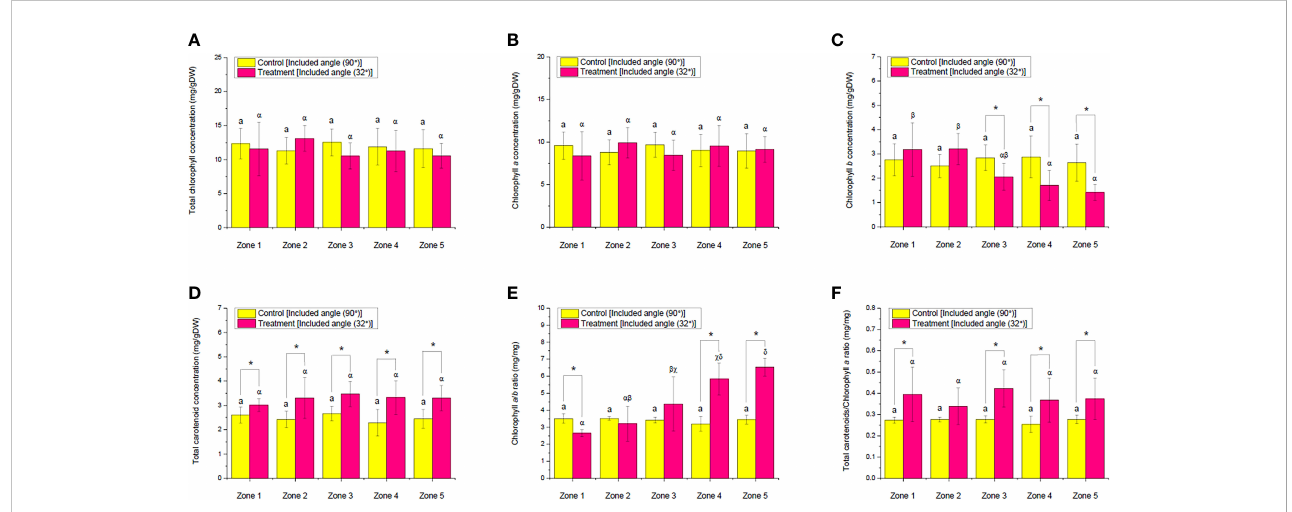
FIGURE 12 Comparison of the concentration of (A) total chlorophylls, (B) chlorophyll a , (C) chlorophyll b and, (D) total carotenoids as well as (E) chlorophyll a / b ratio and (F) total carotenoids/chlorophyll a ratio of choy sum shoots at seedling stage on day 16 grown in an indoor farm rack with and without the application of an adjustable lampshade-type re fl ector (ALR). The asterisks (*) indicate signi fi cant differences found between the control and treatment (Student ’ s t -test; p < 0.05), the lone lowercase letter (a) indicates that there is no signi fi cant difference found among all the zones without the application of ALR, and different Greek alphabets ( a , b , c , and d ) indicate signi fi cant differences found among all the zones with the application of ALR ( N zone1 = 6, N N N N zone2 = 6, zone3 = 6, zone4 = 6, zone5 = 6, one-way ANOVA; Tukey multiple-comparison;